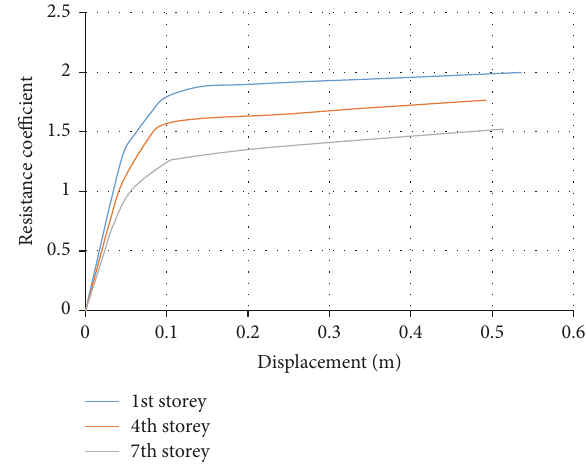
Figure 22: The vertical displacement-resistance coefficient relation- ship of models with different beam parameters after removing the bottom corner column.